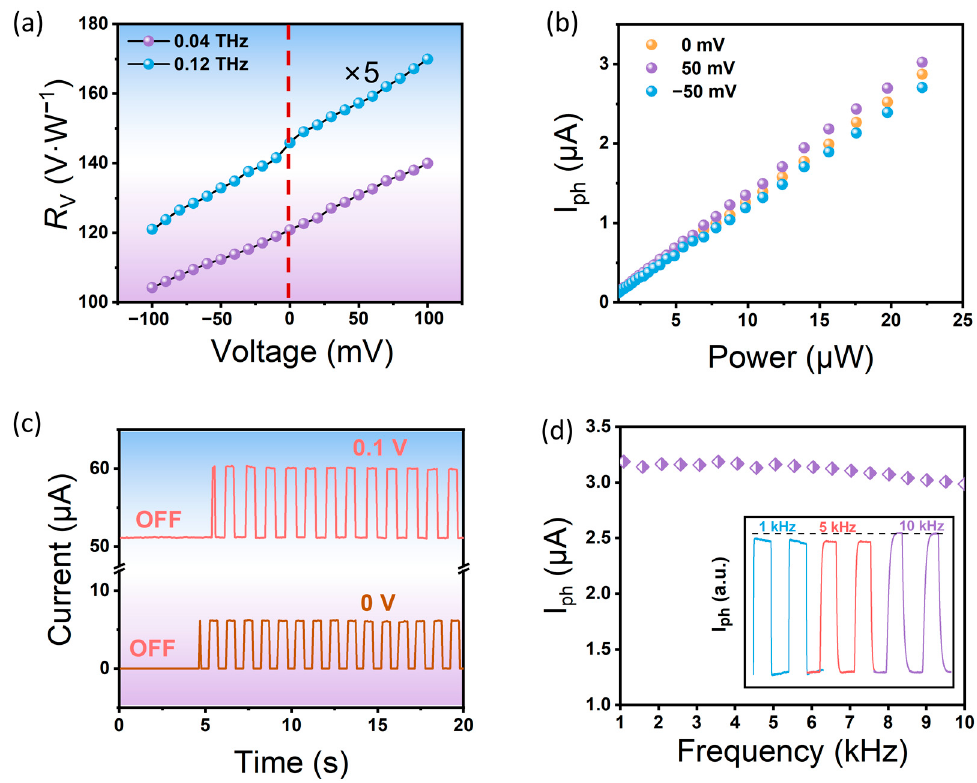
Figure 3. ( a ) The responsivity dependence on the bias of graphene-based THz detectors. ( b ) The photocurrent as a function of radiation power. ( c ) The time-resolved photocurrent of the detector under di ff erent biases. ( d ) The photoresponse dependence on modulation frequency, with the waveform of photoresponse shown for 1 kHz, 5 kHz, and 10 kHz.